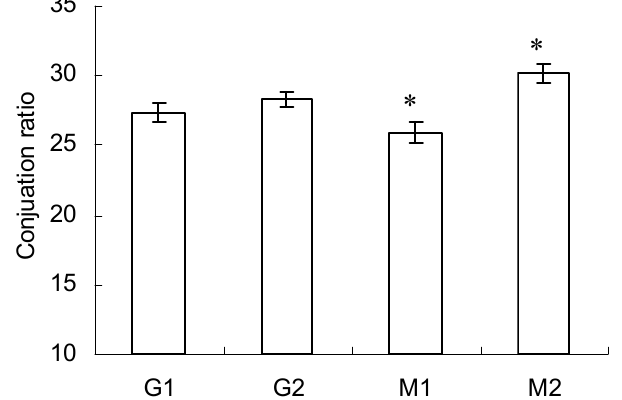
Figure 2. Conjugation ratio of BSA–glucose and BSA–mannose at intensities 10 and 20 kV/cm. Data are mean ± standard deviation, n = 3. * p < 0.05 versus control (G1).